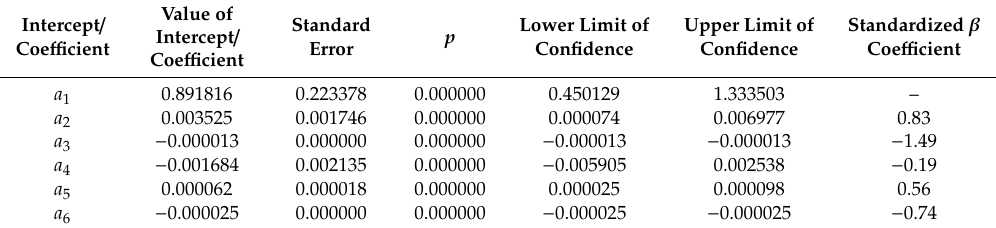
Figure 3. Visualization of 3D model of mass yield ( MY ) of pruned biomass torrefaction. Table 1. Statistical evaluation of mass yield ( MY ) model of pruned biomass torrefaction.